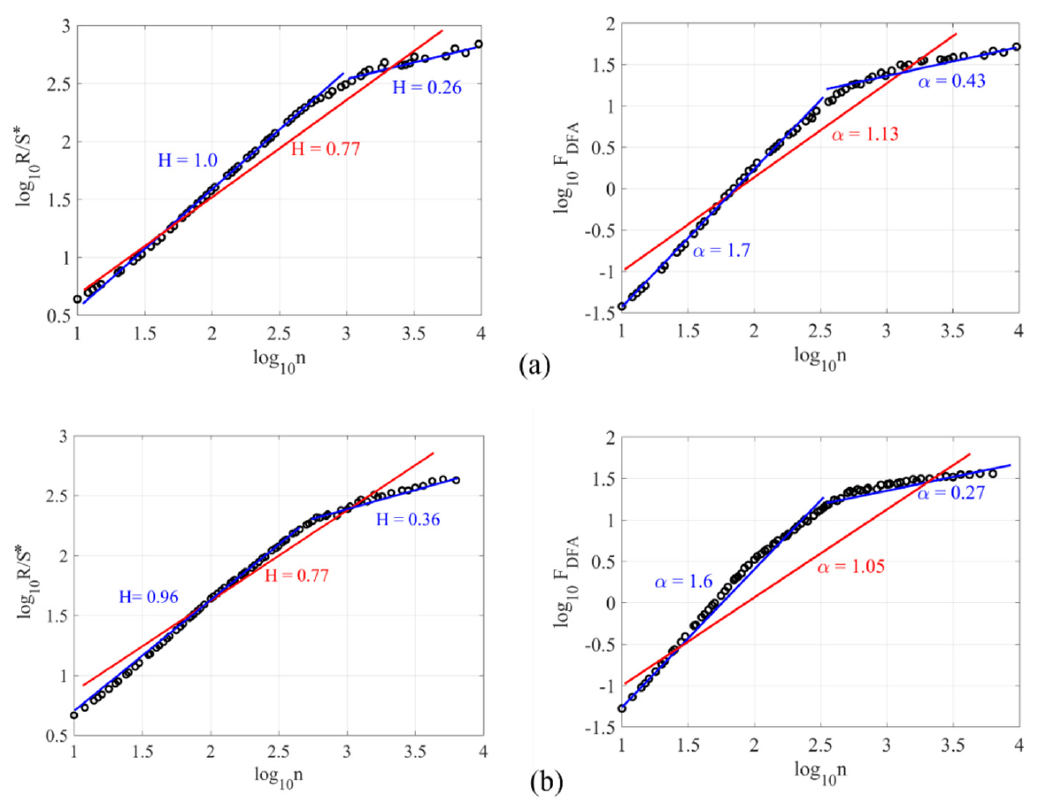
Figure 15. Details of the Hurst and DFA exponents for ( a ) signal #84 at normalized time 0.59; ( b ) signal #127 at normalized time 0.65.